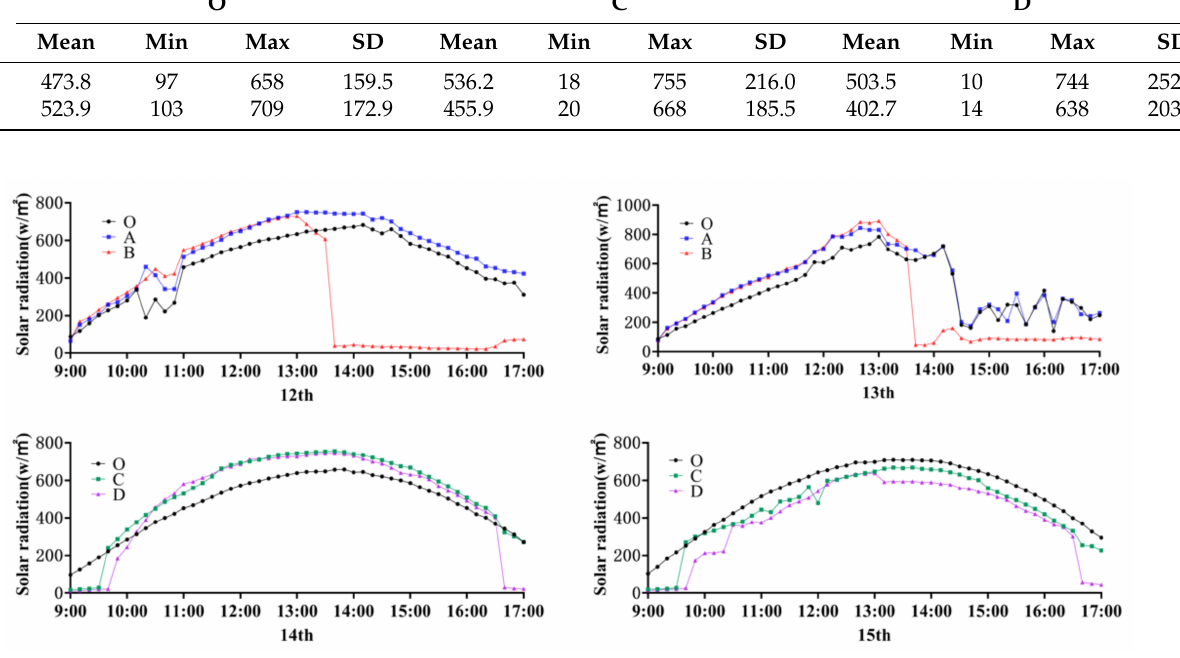
Figure 8. Comparison of solar radiation changes in different